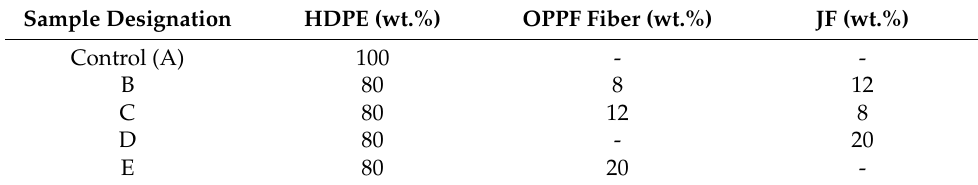
Table 1. Mix Ratio for HDPE/OPPF Fiber/Jute fiber (JF)